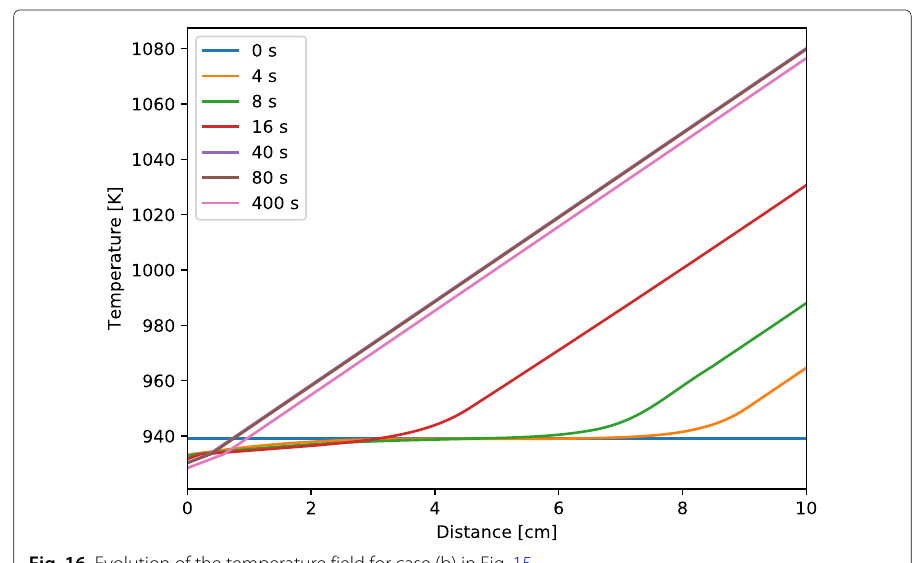
Fig. 16 Evolution of the temperature field for case (b) in Fig. 15